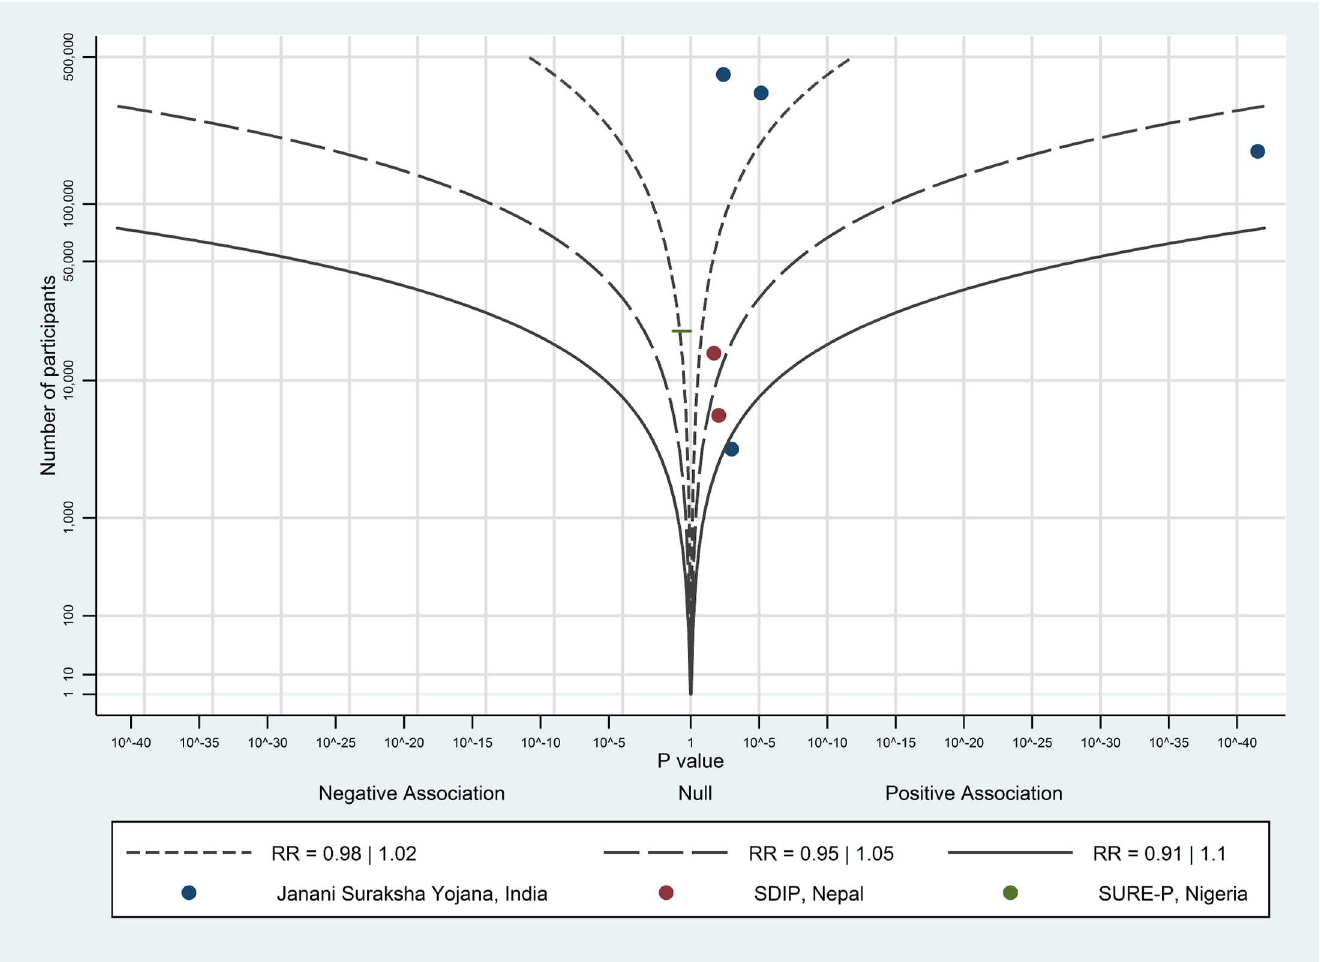
Fig 5. Albatross plot for effect of short-term cash payments on births with a skilled birth attendant. SDIP—Safe DeliveryIncentive